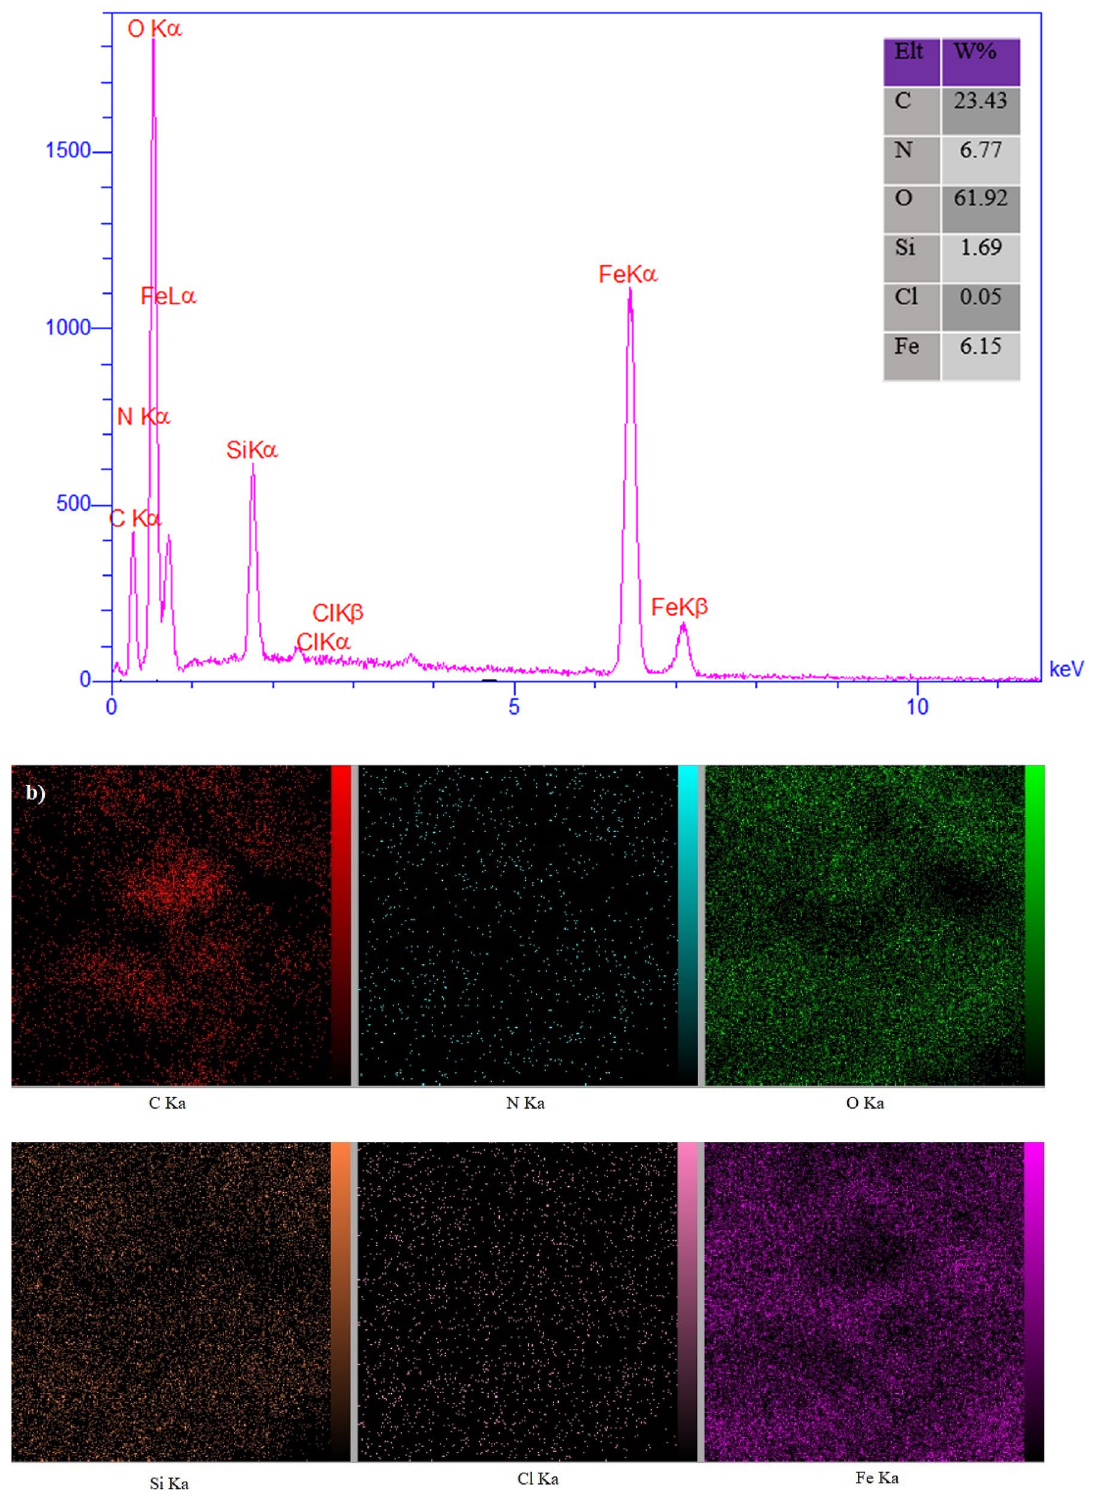
Figure 5. ( a ) Energy dispersive X-ray analysis (EDX) of Fe 3 O 4 @SiO 2 /ECH/IG and ( b ) elemental mapping of C (red); N (blue), O (green), Fe (violet), Si (orange) and Cl (pink) atoms for Fe 3 O 4 @SiO 2